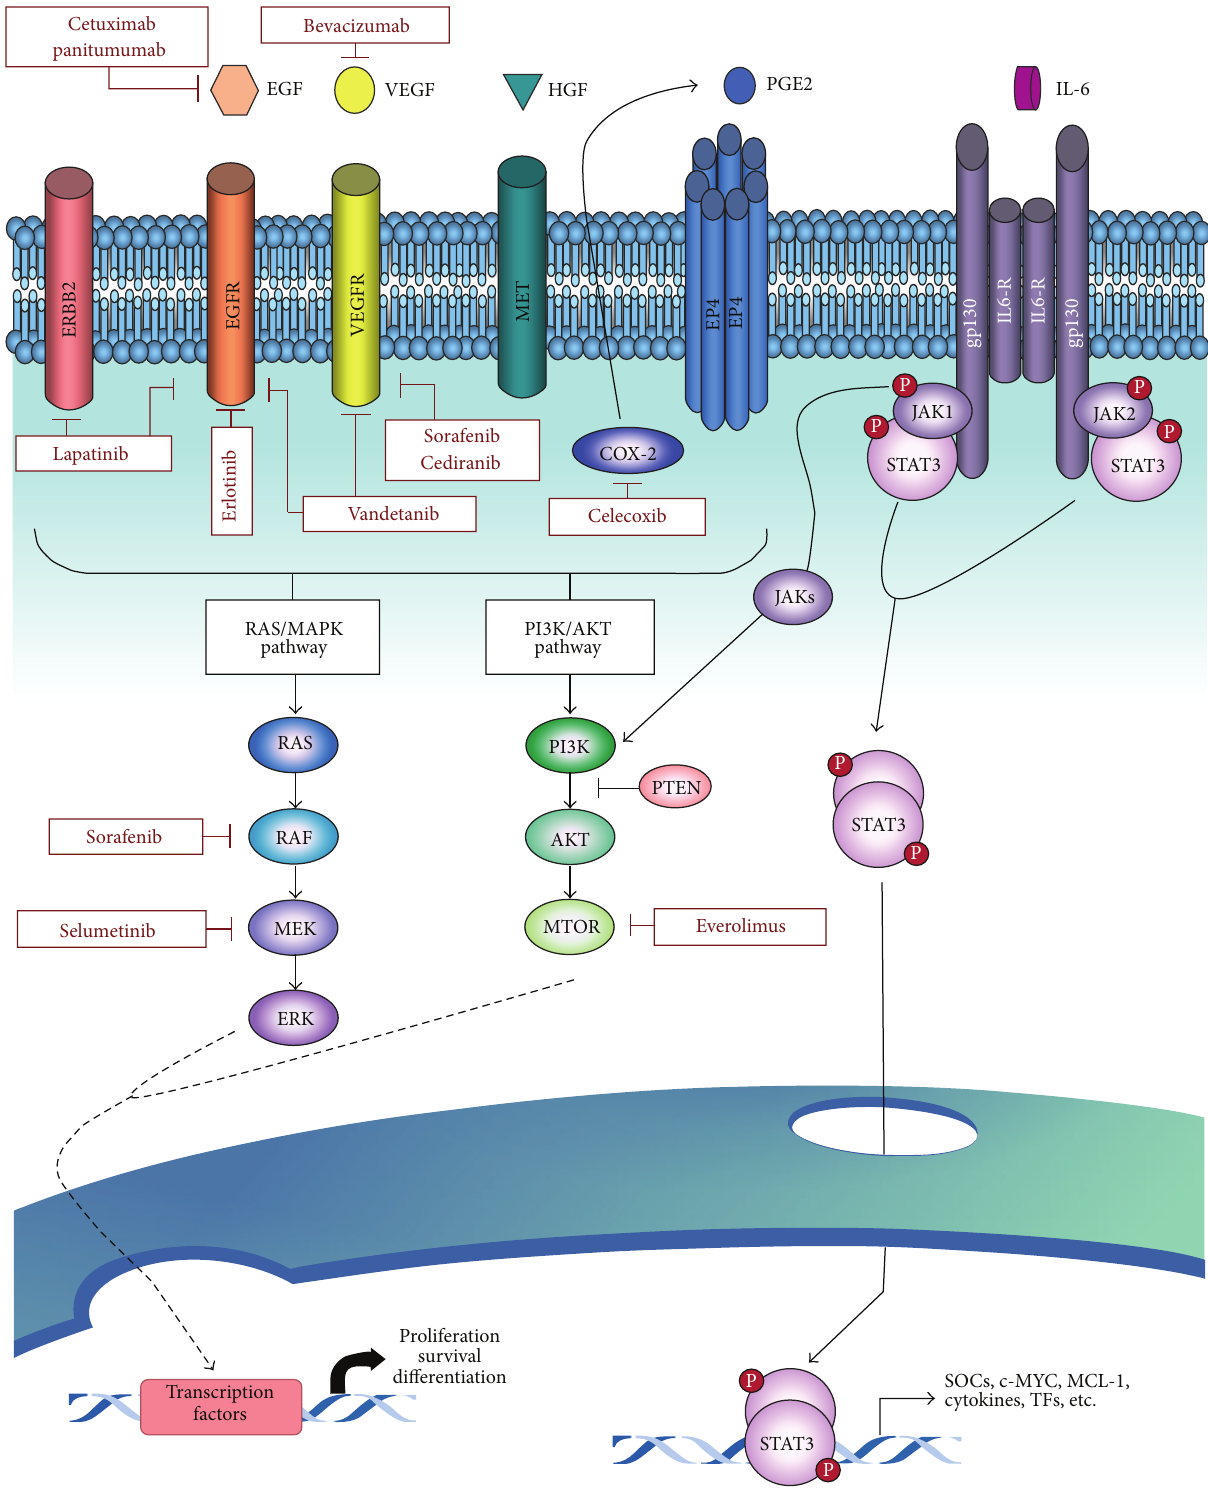
Figure 3: Signaling pathways involved in intrahepatic cholangiocarcinoma and the corresponding molecular therapies. Reprinted from McMilan Publishers Ltd.: Oncogene